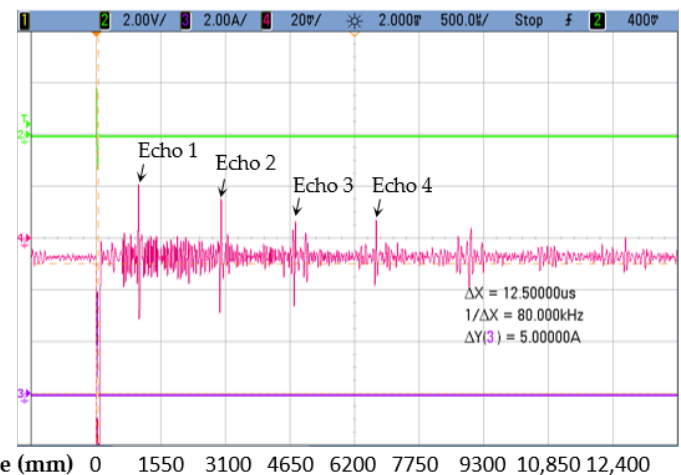
Figure 17. Received echoes using full-bridge (FB).